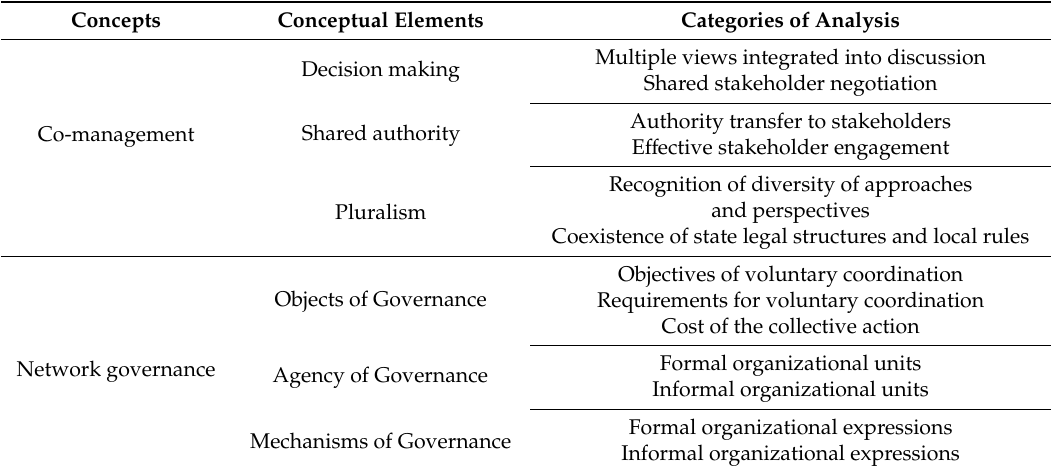
Table 1. Framework of the concepts and categories of